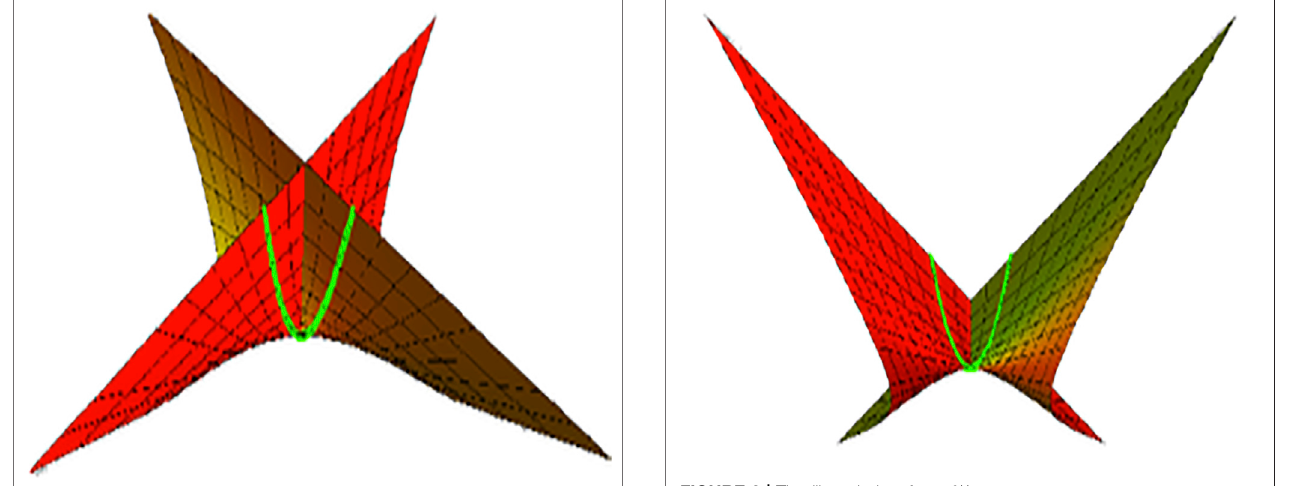
FIGURE 3 | Timelike-ruled surface, ϑ ( t ) = − t .